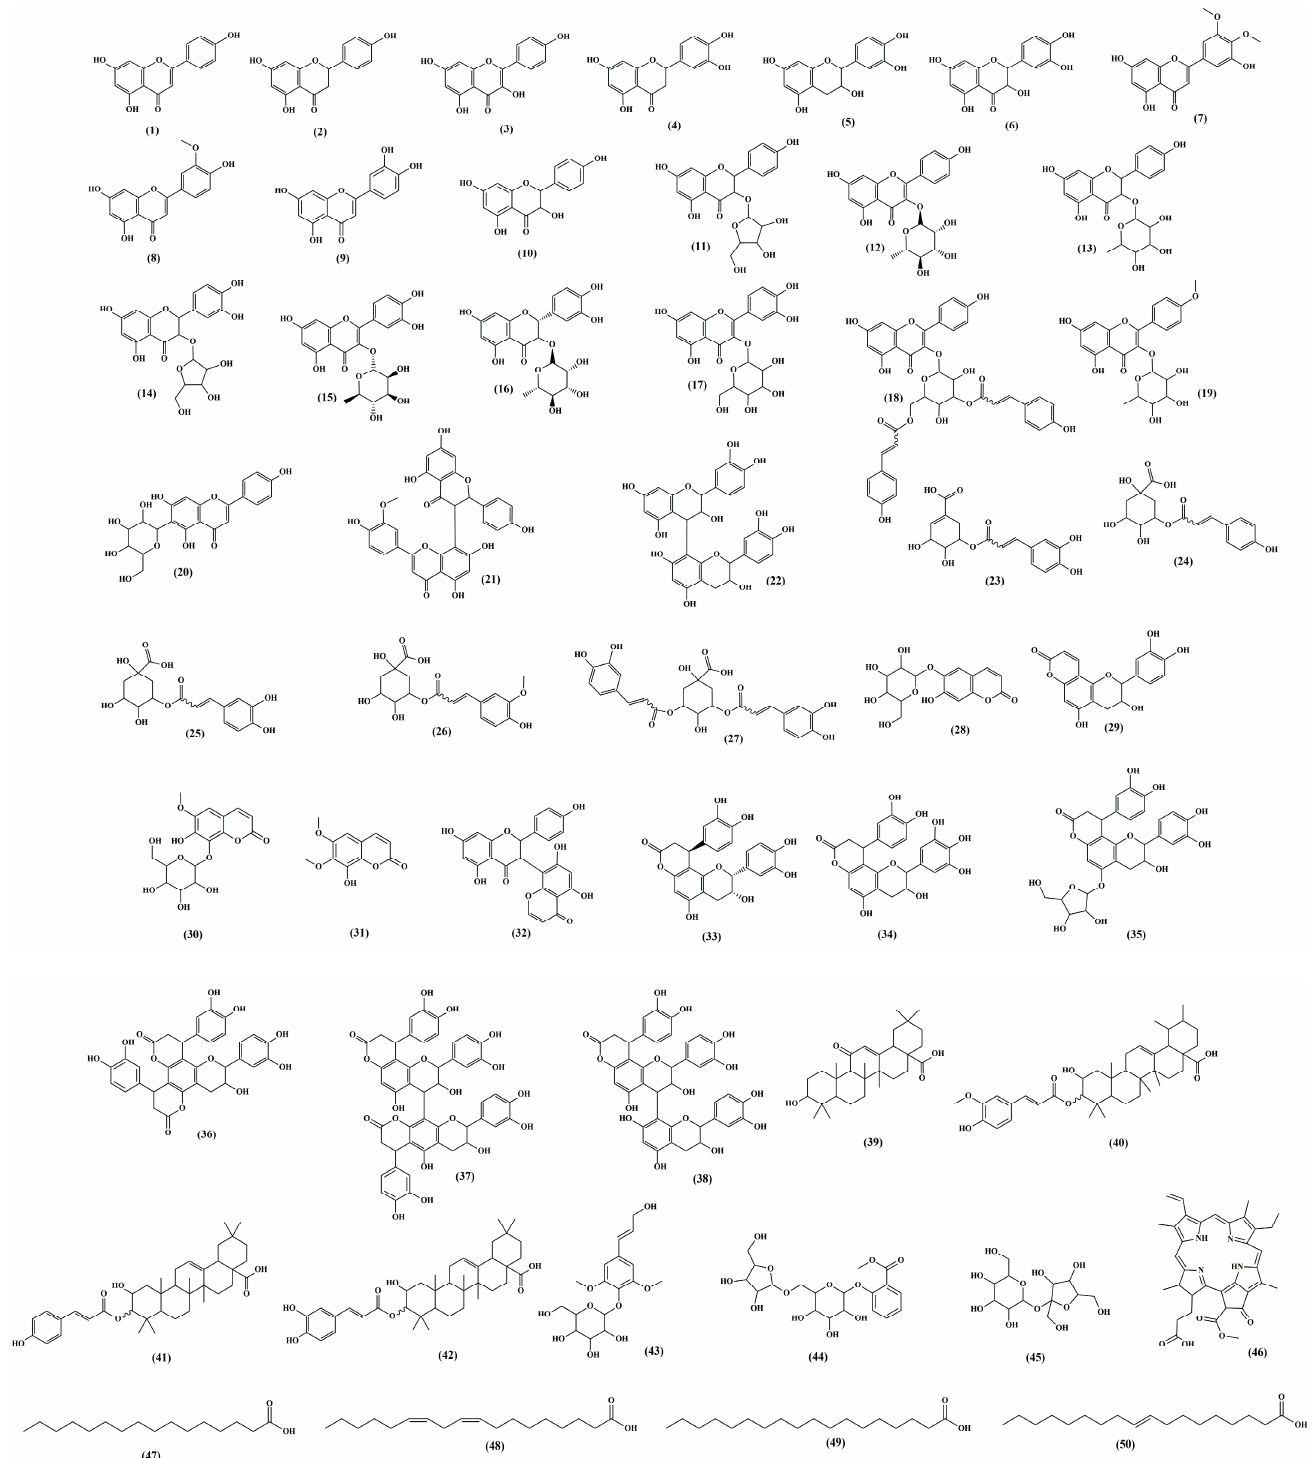
Figure 8. Dereplicated compounds from A. uleanus leaves, roots, bark, and stem bark extracts.